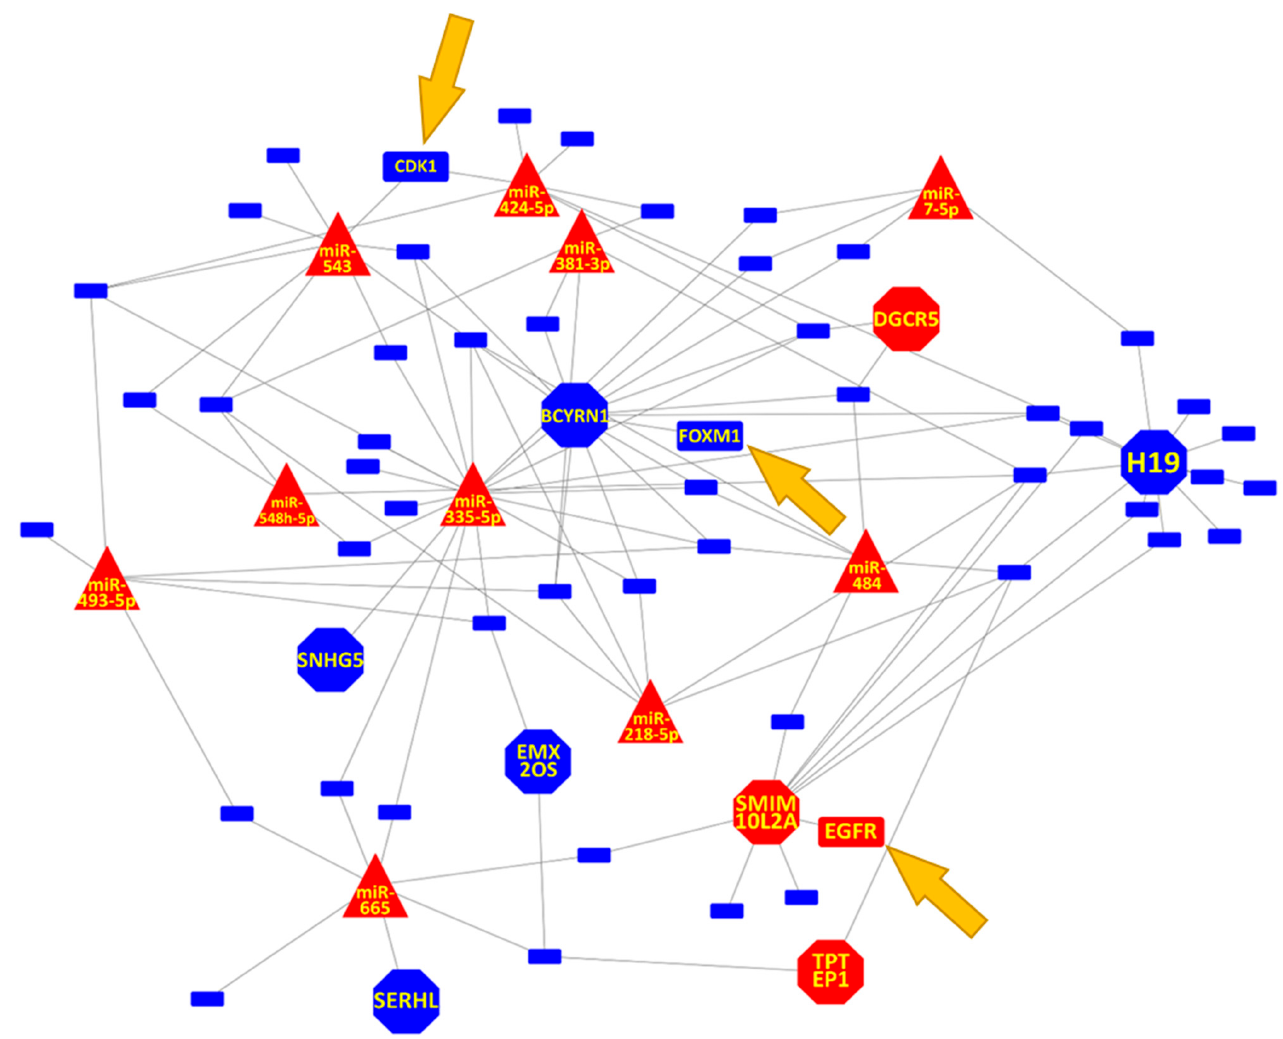
Figure 3. Network representation of lncRNAs and miRNAs gene targets for prostate cell senescence. Only genes related to DNA Repair are presented. The gene target EGFR (belonging to the Prostate Cancer KEGG pathway) is highlighted as is FOXM1, CDK1 , (from the Cellular Senescence pathway). The lncRNAs LINC00152 and LINC00313 are not depicted as they do not have any gene target mapping to either the Prostate Cancer and Cellular Senescence pathways. Blue indicates down- regulated and red up-regulated in senescent cells relative to non senescent cells. Genes are presented as rectangles, miRNAs as triangles, and lncRNAs as octagons. EGFR , FOXM1 , CDK1 are indicated with arrows.